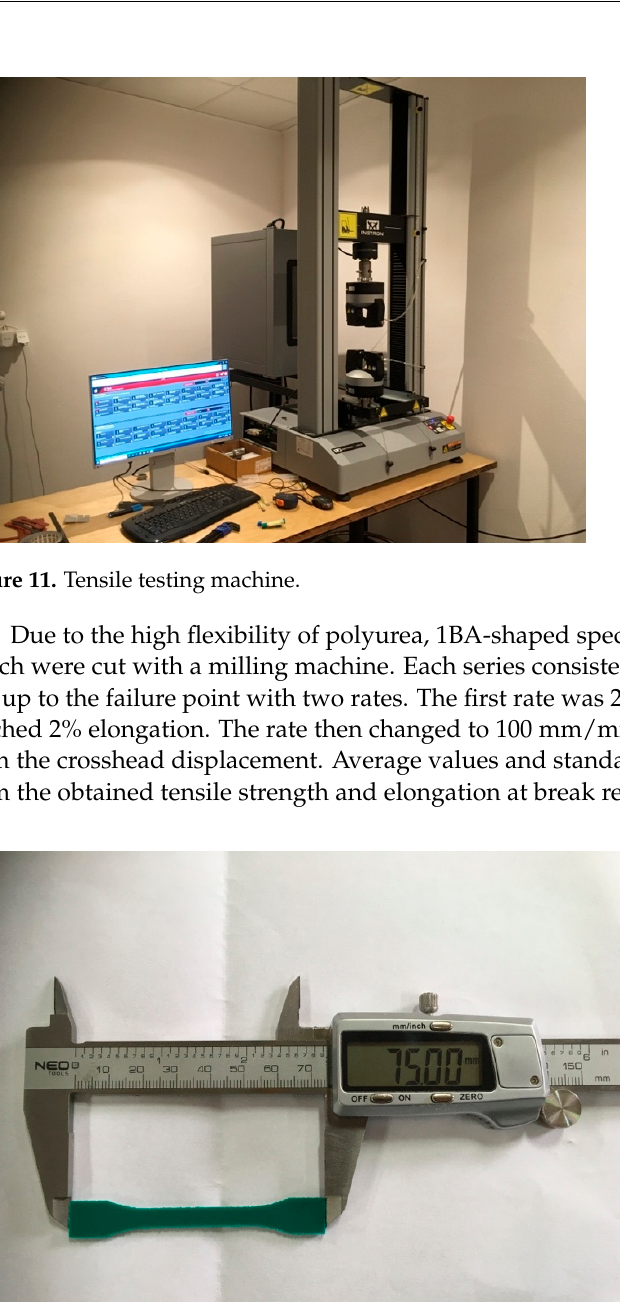
(b) Figure 10 . ( a ) Point-to-point and ( b ) vertical resistance measurement . 3.2.2. Fourier Transform Infrared Spectroscopy (FT-IR) The Fourier transform infrared spectroscopy measurements were performed by Bruker IFS 113 V spectrophotometer with a diamond cell (the quest single reflection ATR accessory IRAffinity-1) in automatic mode. Scanning conditions were as follows: wave- number range from 4000 to 500 cm − 1 ; resolution 2 cm − 1 . Five scans were performed for each analysis. This test allows verifying the correct mixing of the ingredients and the correct course of the reaction.